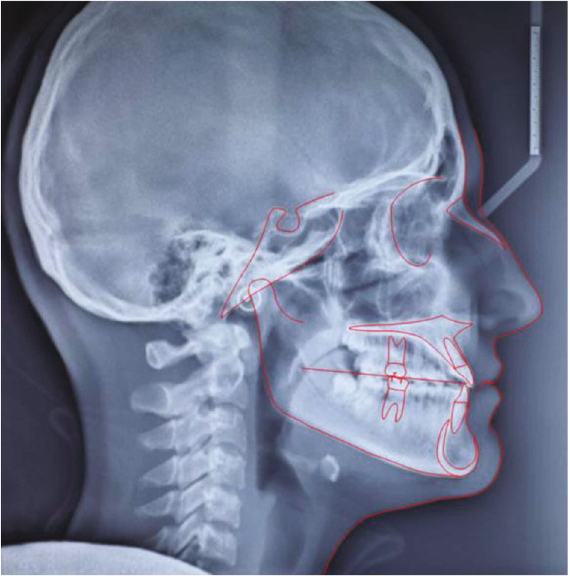
Figure 11: Final lateral cephalogram. Table 2: Final cephalometric